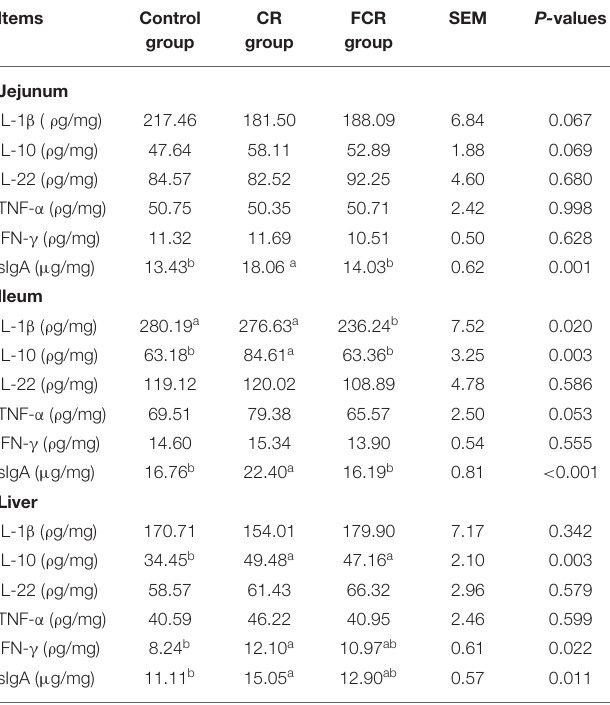
TABLE 4 | Effects of cassava residue (CR) or fermented cassava residue (FCR) on microbial diversity indices in the ileum and colon of piglets.